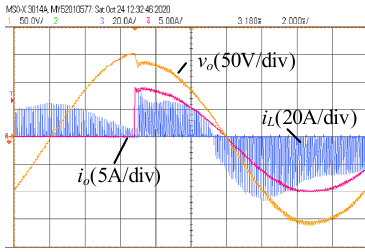
Figure 13. Dynamic response of the inverter to the step ‐ change in the output power from 0 to 1 kW. Time: 2 ms/div.